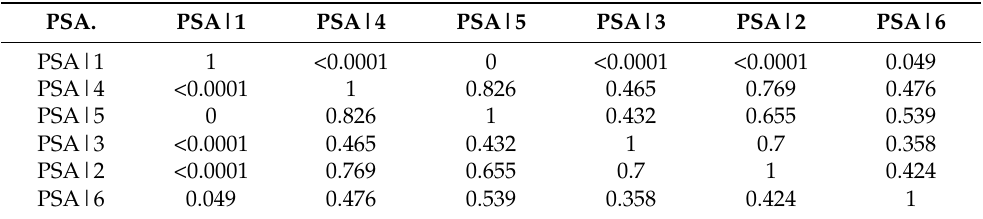
Table 6. p -Values of specific area on which the ethical code primarily focuses on and extent of the ethical code after Bonferroni-corrected significance level: